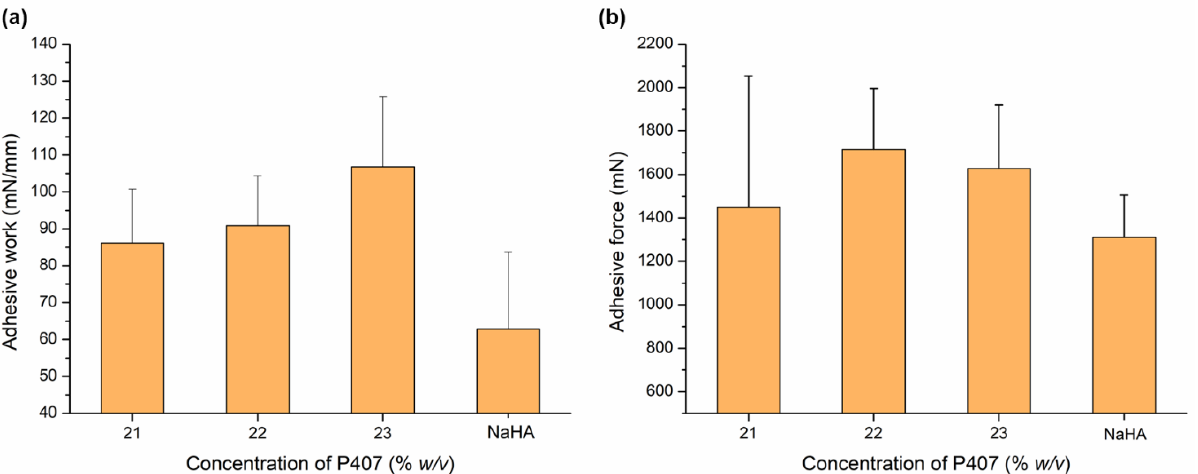
Figure 3. Effect of P407 concentration on gel strength ( a ) and mucoadhesive strength ( b ) in comparison to 0.5% w/v NaHA solution. Data are presented as means ± SD, n = 3.